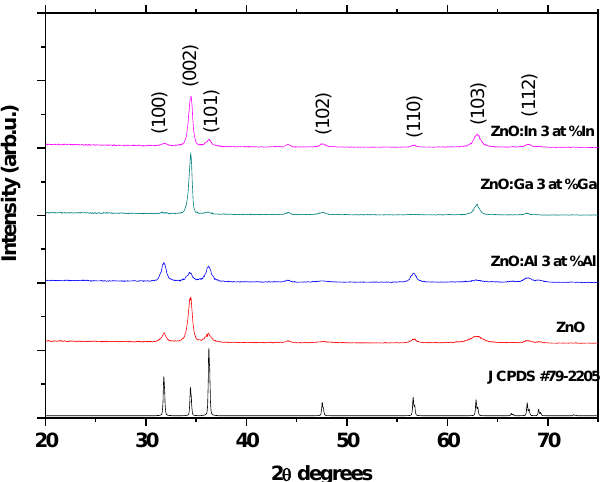
Figure 1. XRD spectra of i-ZnO, Al, Ga, and In samples compared with a ZnO pattern. The crystallite sizes were quantitatively evaluated from XRD data using the Debye– Scherrer equation (Equation (1)) [19]: